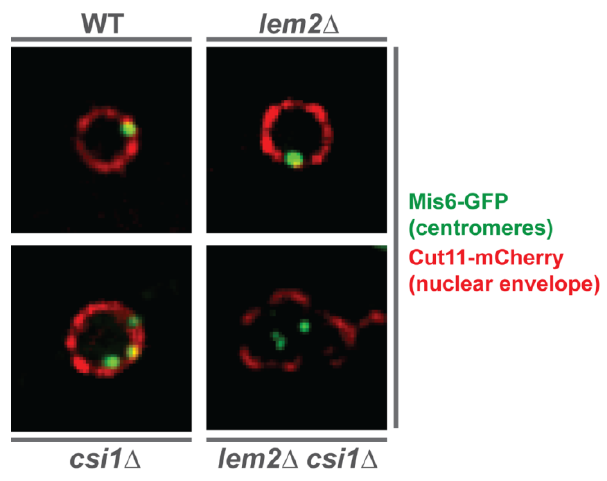
FIGURE 1: Centromeres delocalize from the nuclear periphery in the double mutant lem2 ∆ csi1 ∆. Images show the relative locali- zation of centromeres (green) with respect to the nuclear enve- lope (red) in WT and indicated mutant nucleus. The kinetochore protein Mis6 is tagged with GFP for visualizing centromeres, while the nuclear pore protein Cut11 is fused to mCherry for detecting the nuclear